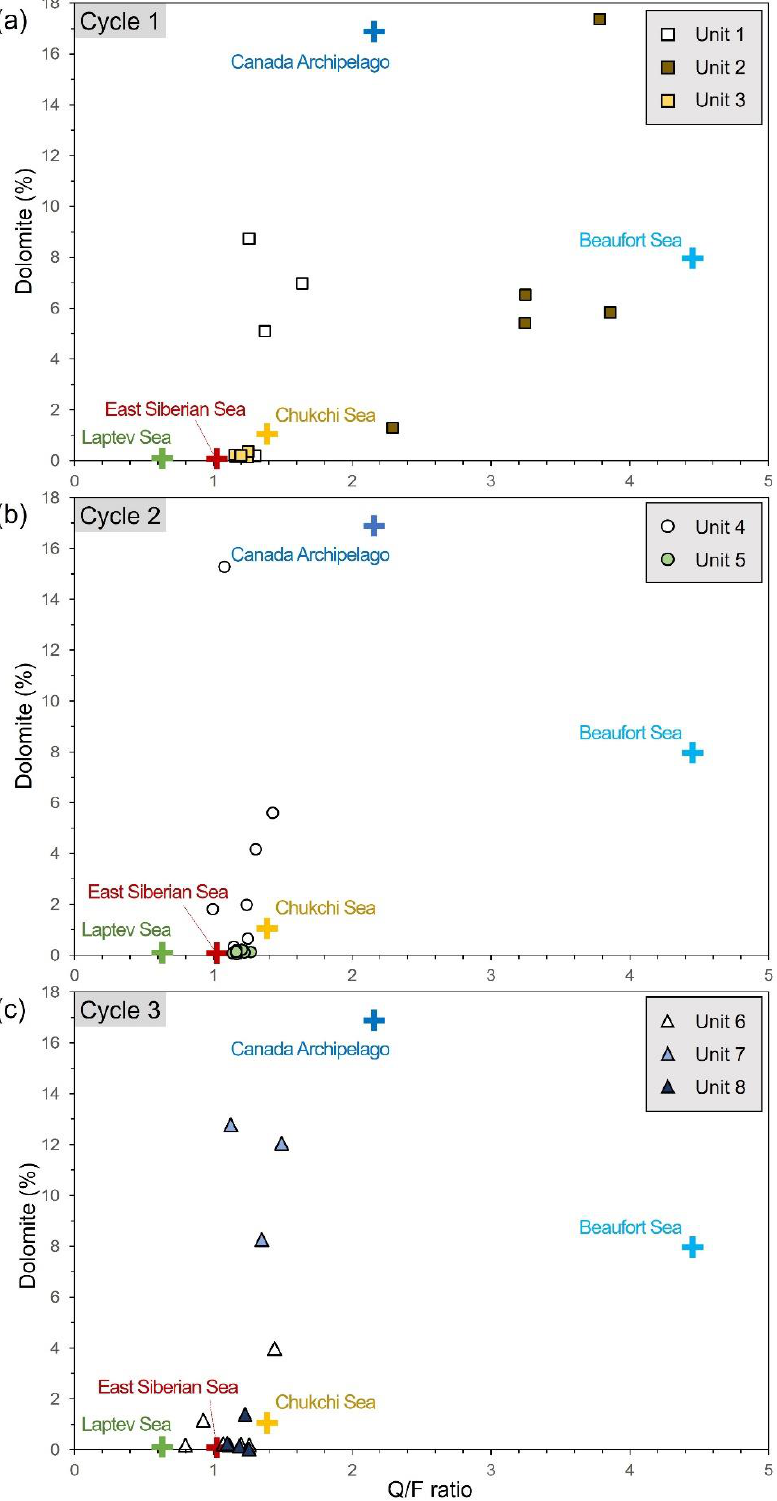
Figure 4. Discrimination plots showing variations in Q/F ratio vs. dolomite during ( a ) Cycle 1, ( b ) Cycle 2, and ( c ) Cycle 3. Mineralogical data of potential provenances are also shown for comparison [18]. Q/F: quartz/feldspar.